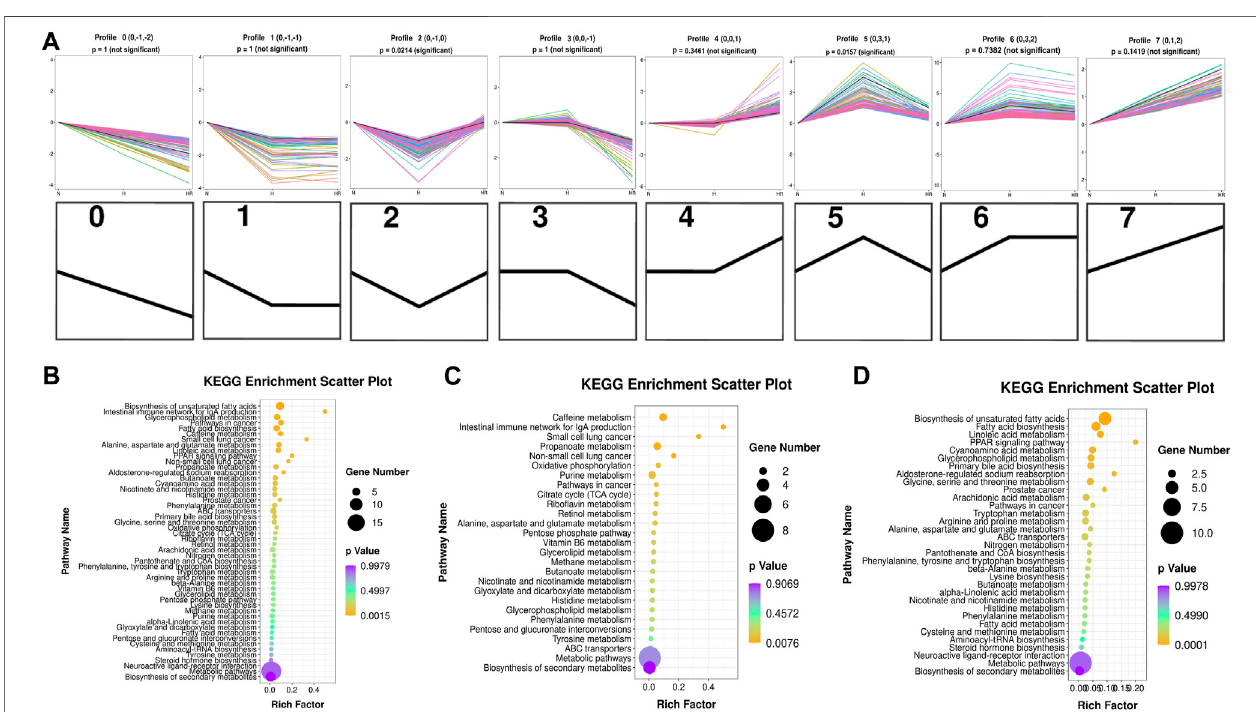
FIGURE 6 | Trend analysis of differentially expressed metabolites. (A) Expression trend of metabolites. All the distinct color lines represented different second metabolites. The top seven fi gures indicated the trend of all different metabolites. And the bottom seven black fi gures denoted the trend pro fi le. (B) KEGG enrichment scatterplotof trends 2and 5. (C) KEGG enrichment scatterplot oftrend 2. (D) KEGG enrichment scatterplot oftrend 5. N, normal group; H, high-fat diet group; and HR, high-fatdietplusREV treatment group.Richfactorindicatesthenumberofdifferentially expressedgeneslocatedintheKEGG/the totalnumberofgeneslocatedin the KEGG. The smaller the p value, the higher the concentration of